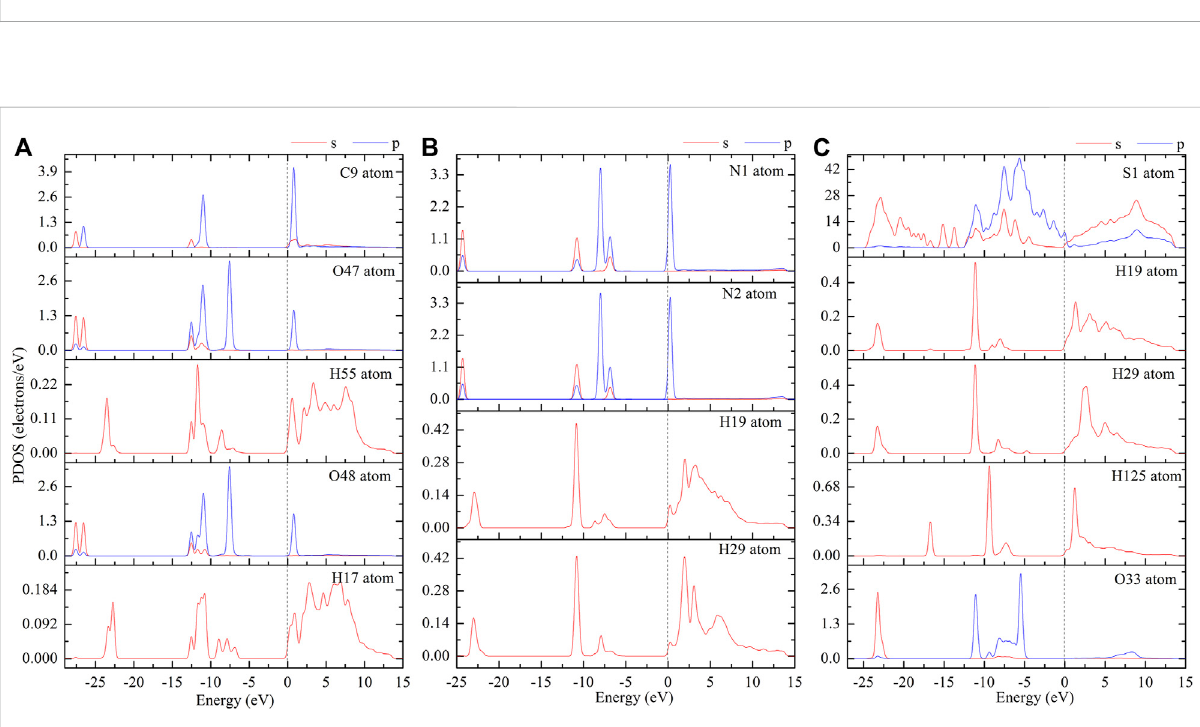
FIGURE 6 FinaladsorptionmodelsofCO 2 , N 2 , andH 2 Smolecules, thegreen-dashedlines denotetheinterfacialbonds, and spheres with white, red,blue, yellow, and grey colors denote H, O, N, S, and C atoms, respectively.